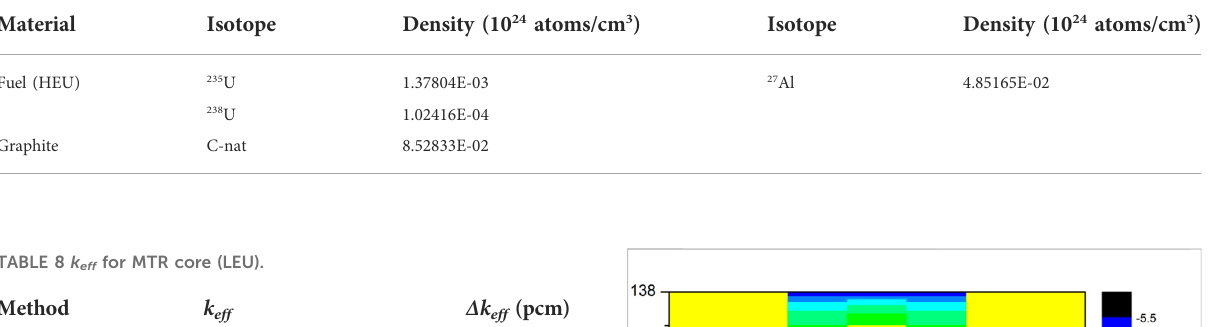
TABLE 7 Material compositions for MTR core.